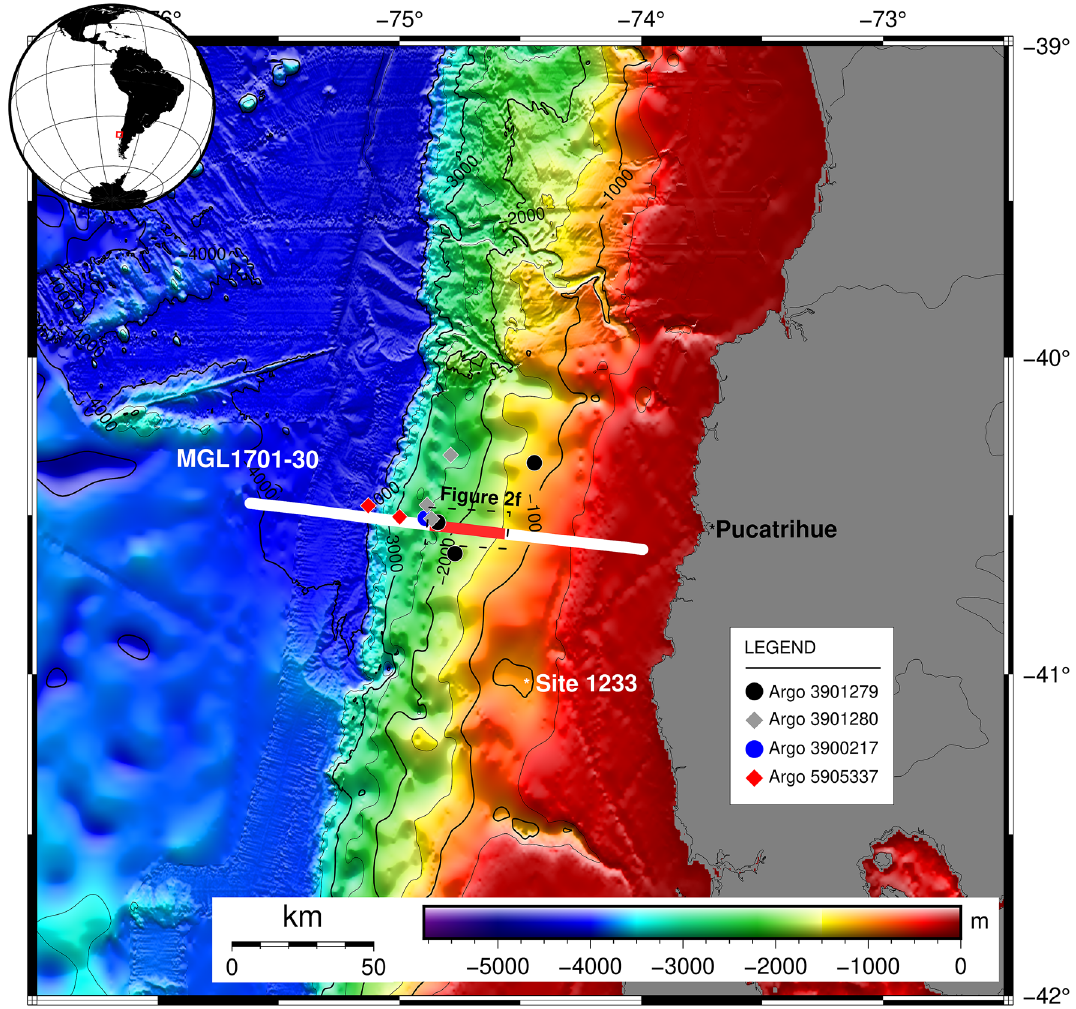
Figure 1. Study area. Location map of the MGL1701-30 seismic and CHIRP lines (white solid line). The red line indicates the analyzed portion of the seismic and CHIRP lines, the dashed black line the location of bathymetry zoom (Fig. 2f) and the white circle is the location of site 1233 drilled by ODP during 2002. The locations of ARGO used for the modeling are reported and explained in legend. The map was generated using GMT (v.6.2.0; https:// www. gener ic- mappi ng- tools. org/) 49